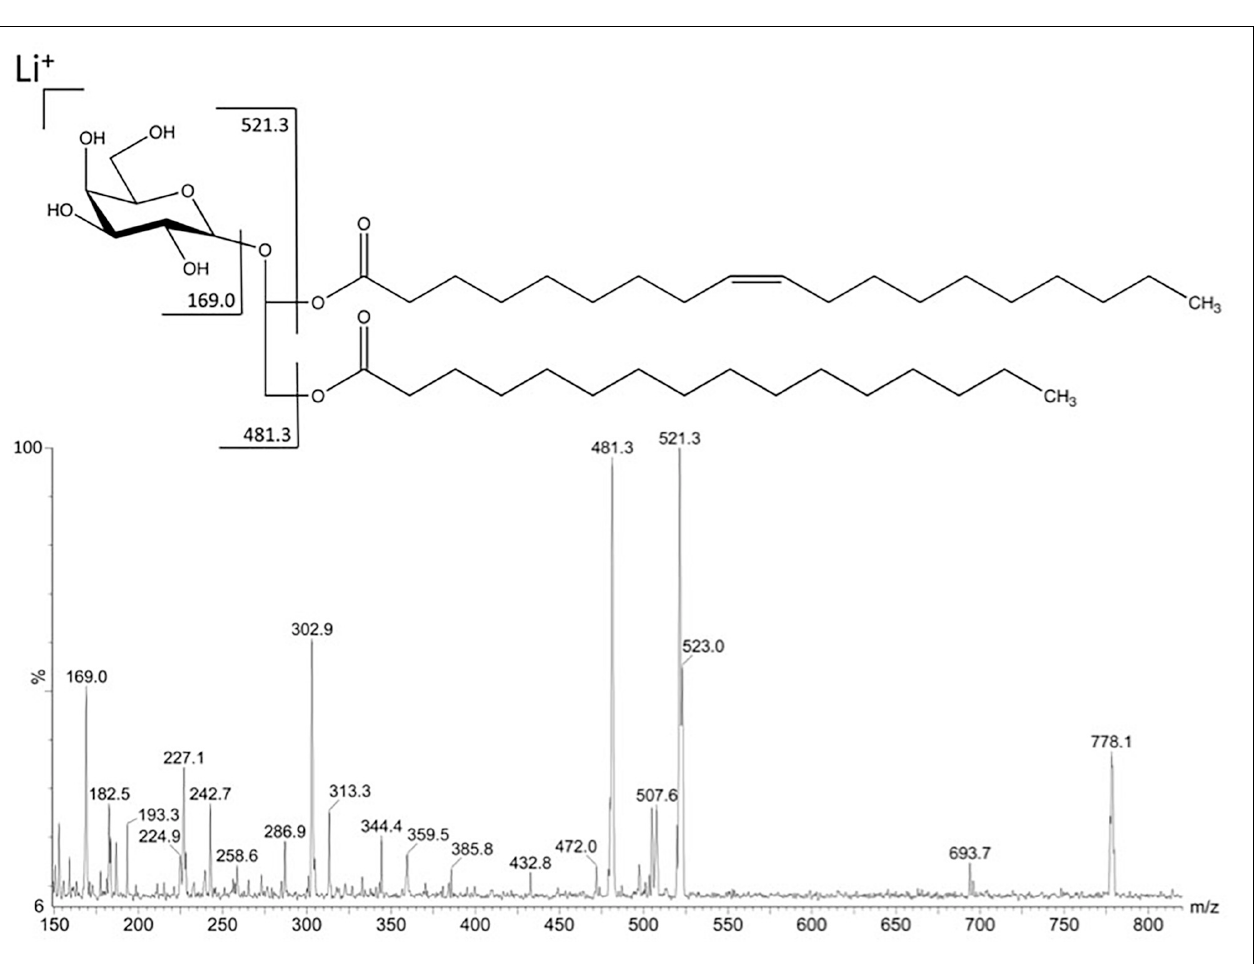
FIGURE 2 | Fragmentation in positive mode of the major ion at m/z 778.1 detected in fraction